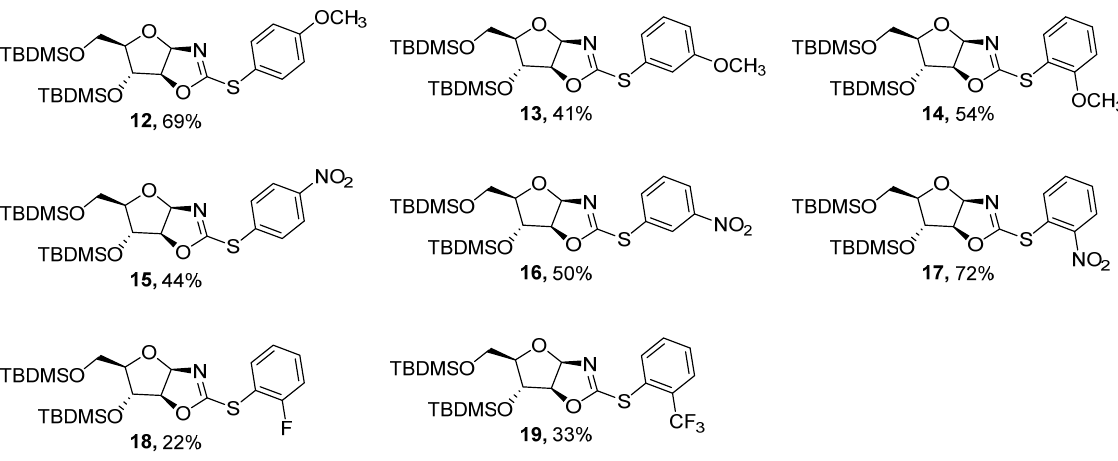
Figure 2. Synthesized compounds 12 – 19 .